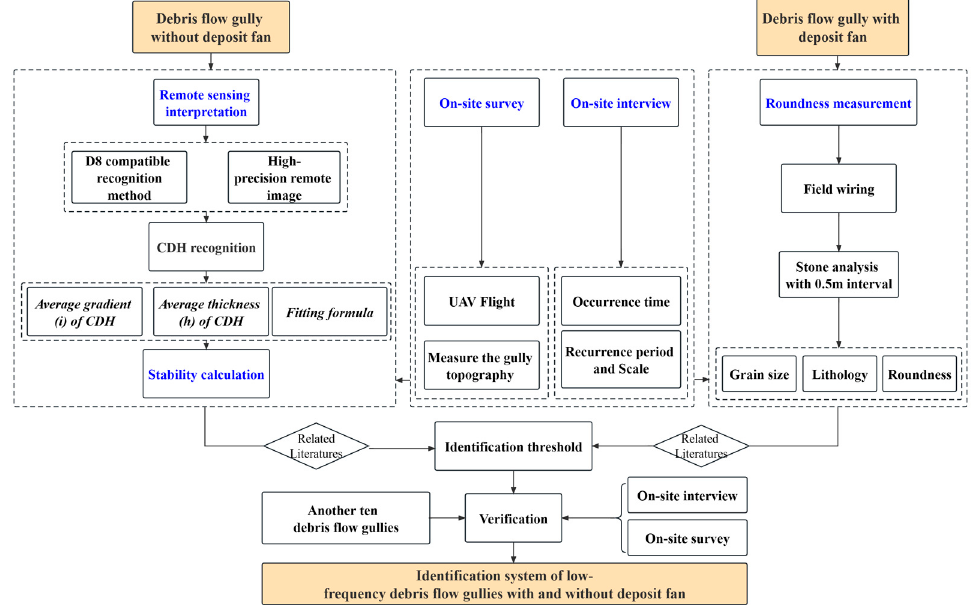
Figure 3. Flow chart of this